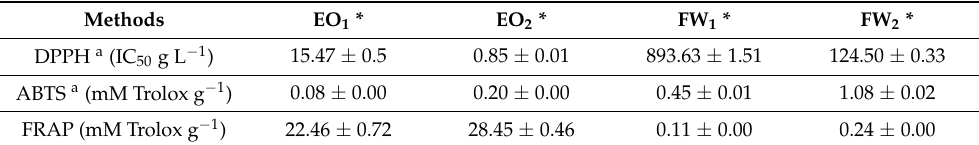
Table 5. Antioxidant capacity of EO S and FW S obtained from new variety of basil (Occimum basilicum L., fam. Lamiaceae